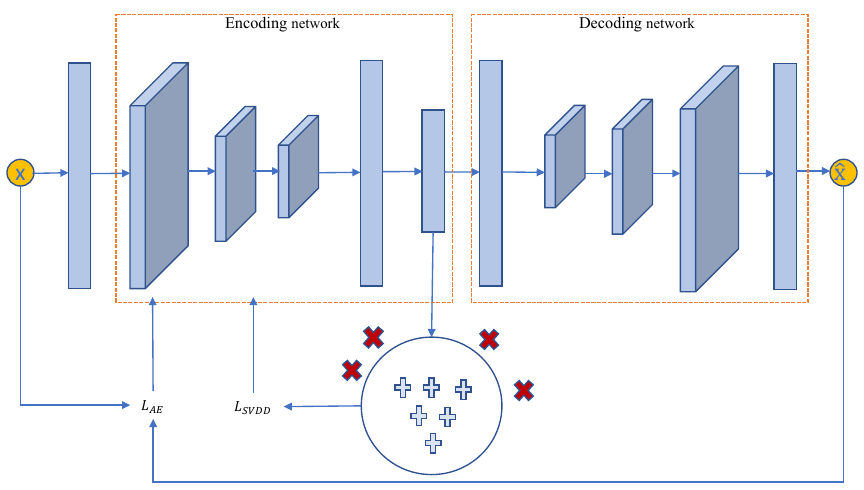
Figure 1. The architecture of the proposed